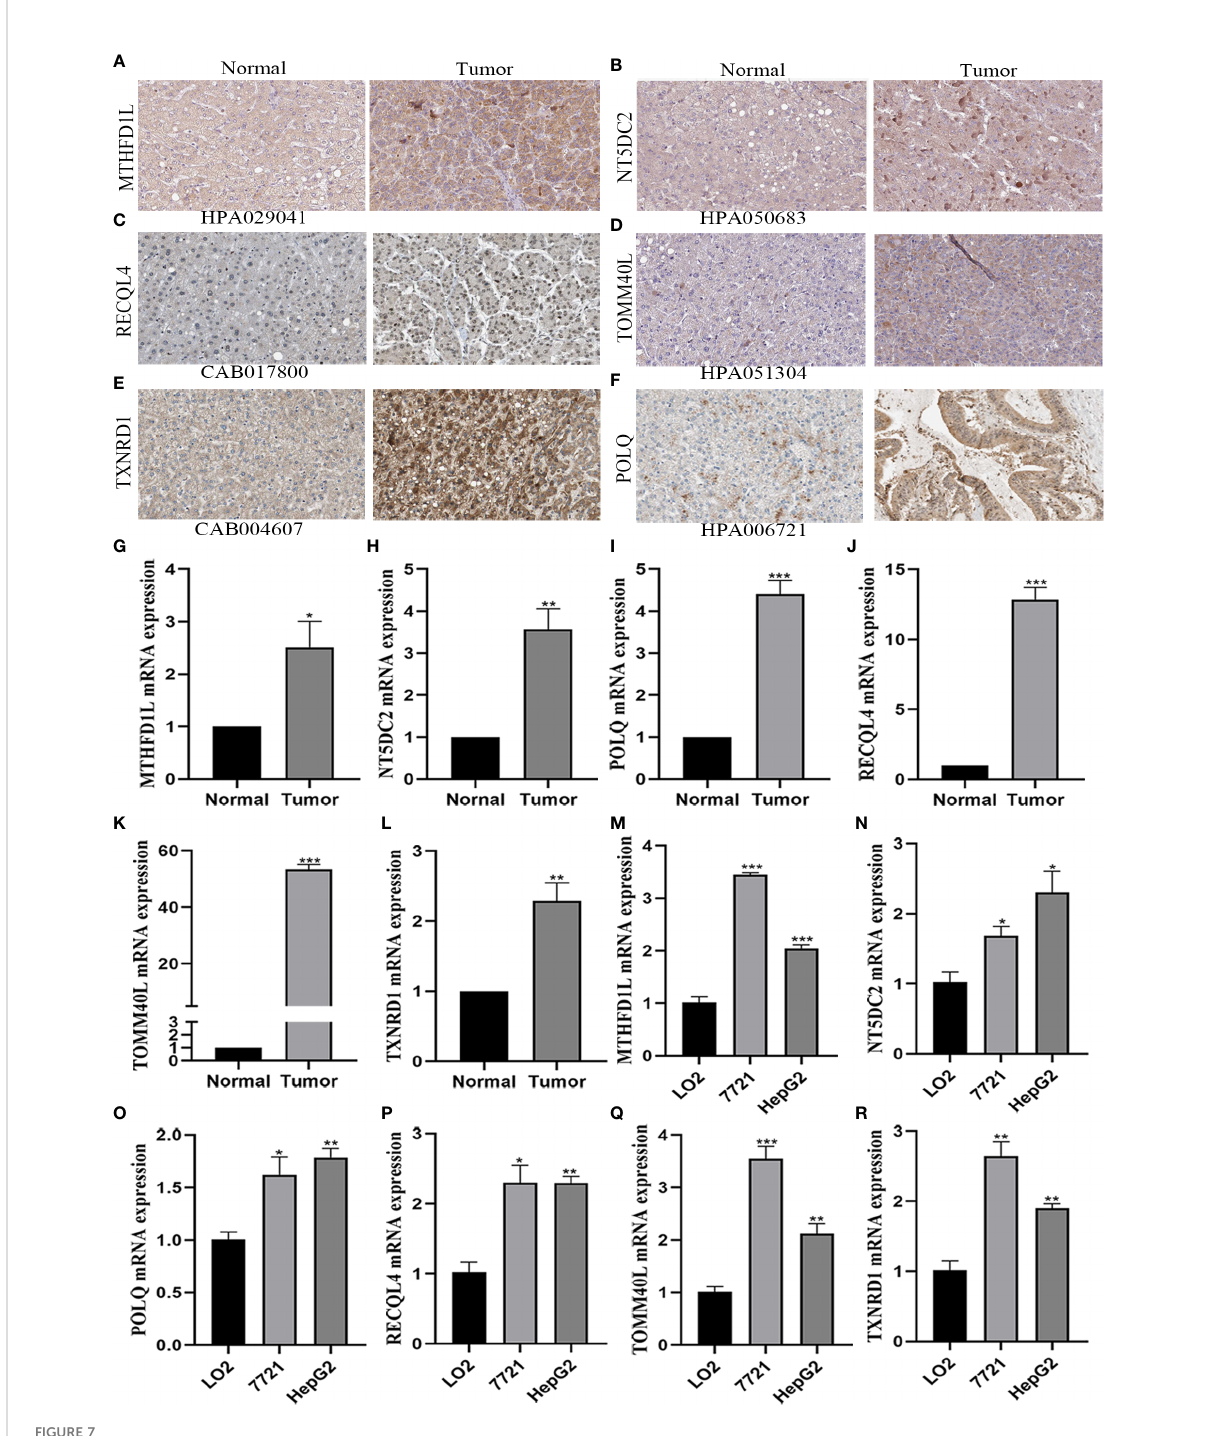
FIGURE 7 Veri fi cation of the expression of six mitochondrial-related genes by immunohistochemistry and qRT-PCR analysis. (A – F) The protein expression of six mitochondrial-related genes in HCC and adjacent normal tissues by immunohistochemistry. (A) MTHFD1L. (B) NT5DC2. (C) RECQL4. (D) TOMM40L. (E) TXNRD1. (F) POLQ. (G – R) The mRNA expression of six mitochondrial-related genes in HCC tissues and cell lines by qRT-PCR analysis. (G, M) MTHFD1L. (H,N) NT5DC2. (I, Q) POLQ. (J, P) RECQL4. (K, Q) TOMM40L. (L, R) TXNRD1. *P<0.05, **P<0.01,